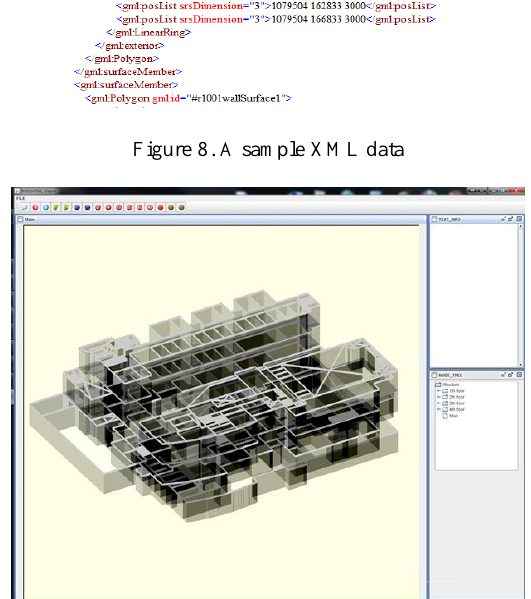
Figure 9. ISDM Viewer: Sample